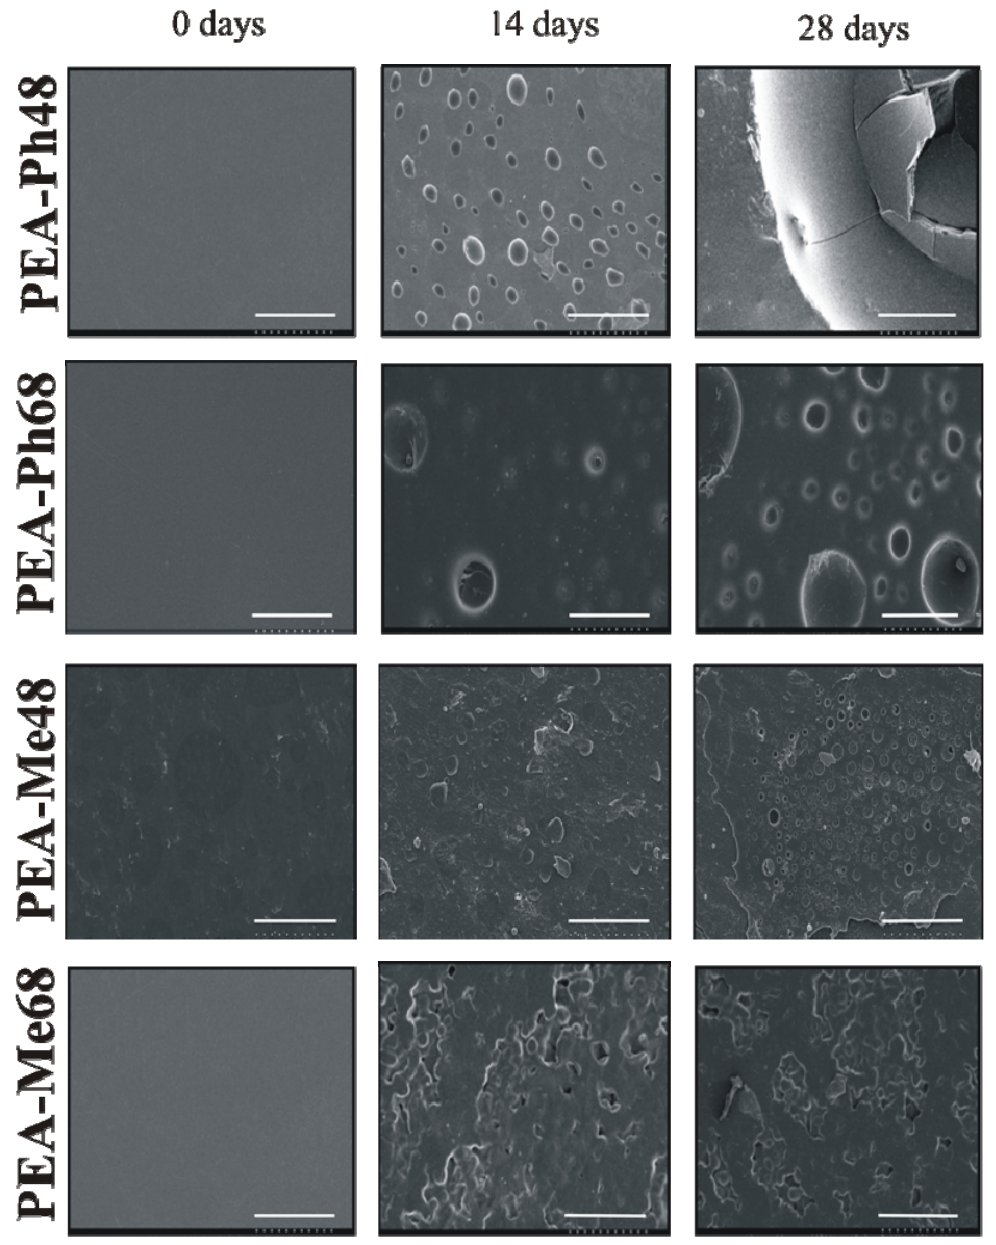
Figure 7. SEM images of PEA films degraded in PBS at 37 °C for up to 28 days. At day 28, PEA-Ph48 and PEA-Ph68 cracked or blistered wheras PEA-Me48 and PEA-Me68 eroded. Scale bar = 100 μ